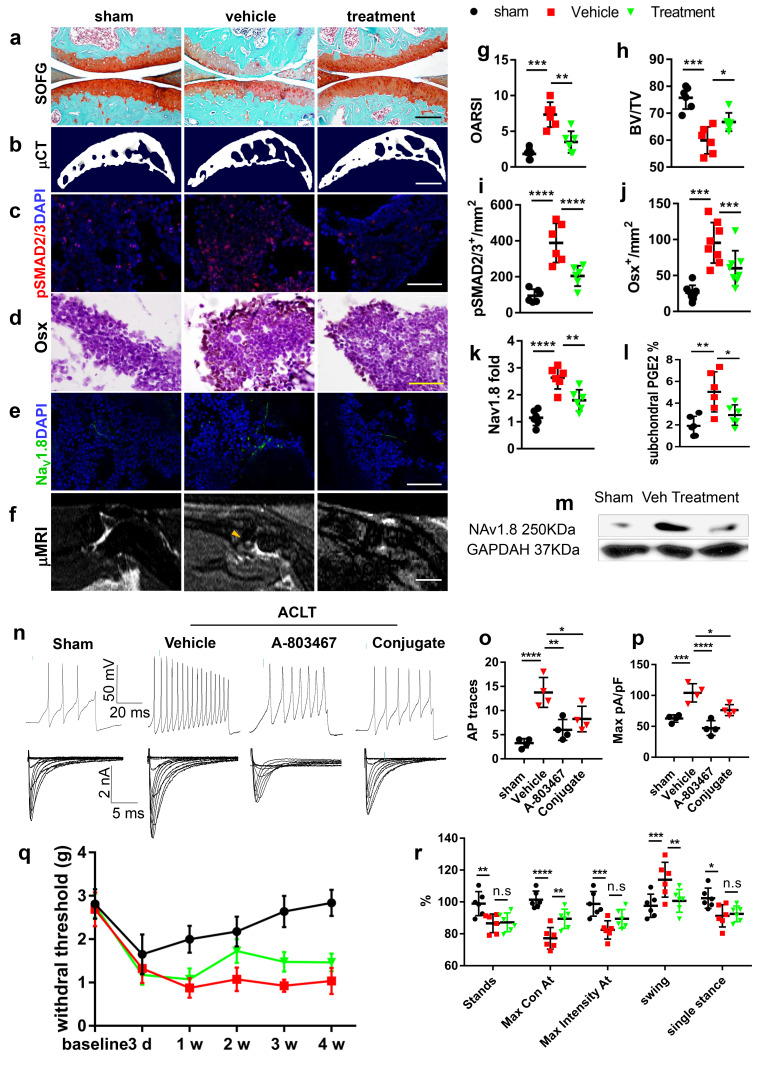
Targeting aberrant subchondral bone remodeling reduces NaV1.8+ innervation and ameliorates OA pain.(a–f) Representative photos of Safranin Orange and fast green staining (a), μCT 3D reconstruction (b), pSMAD2/3 (red) and DAPI (blue) immunostaining (c) Osterix immunostaining (d) Nav1.8 (green) and DAPI (blue) immunostaining (e) and T2 weighted fat suppression μMRI image showing bone marrow lesion (yellow arrows) (f) of murine tibial subchondral bone after sham or ACLT surgery at 1 m. Scale bars, 500 μm (a), 2 mm (b), 10 μm (c, d), 20 μm (e), and 5 mm (f), n = 6 per group. (g–l) Quantitative analysis of OARSI score (g), BV/TV (h), number of pSMAD2/3+ cells per mm2 (i) and number of Osterix+ cells per mm2 (j), relative pixel of Nav1.8 immunofluorescence signal (k) and subchondral PGE2 concentrations (l), after sham or ACLT surgery at 1 m. (m) Representative western blots of NaV1.8 and GAPDH of ipsilateral L3-5 DRG lysate, experiments were repeated three times. (n–p) Representative traces of Aps (n upper), maximal current density (n lower), statistical analysis of AP numbers (o) and NaV1.8 currents (p) of DRG 1 month post sham or ACLT. (q, r), left HPWT (q) and catwalk gait analysis (r) n = 6 per group, *p<0.05, **p<0.01, ***p<0.001, ****p<0.0001 compared with the sham-operated group at different time points. Statistical significance was determined by multifactorial ANOVA WITH BONFERRONI POST HOC TEST (j, k, L, m, n, o, q and r) or unpaired Student’s t test (c), and all data are shown as scattered plots with means ± standard deviations.Figure 6—source data 1.Raw data of OARSI, microCT data, Osx, TRAP, pSMAD2/3, subchondral Nav1.8 fiber density, Retrograde tracing, Von Frey tests, GcAMP3 imaging, and electrophysiological recordings.Figure 6—source data 2.Full scan of western blots in Figure 6m.